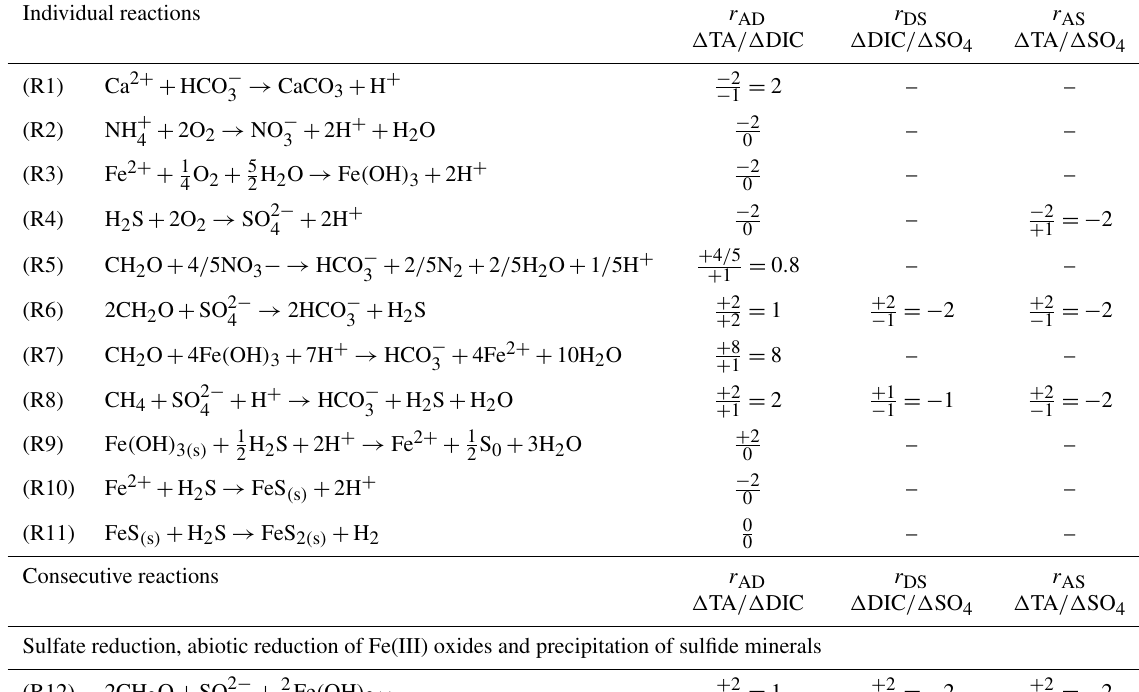
Table 1. Individual and consecutive microbial and abiotic reactions that affect the theoretical (cid:49) TA /(cid:49) DIC ( r AD ), (cid:49) DIC /(cid:49) sulfate ( r DS ) and (cid:49) TA /(cid:49) sulfate ( r AS ) stoichiometric ratios. Note that Reactions (R14) and (R17) include oxidation of H 2 by sulfate reducing bacteria. Individual